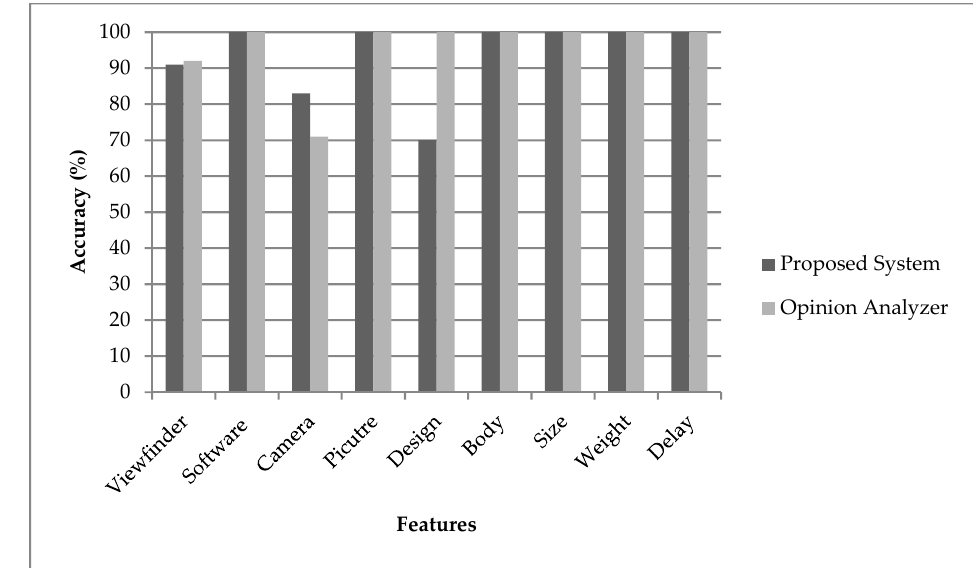
Figure 12. Comparison of proposed system with opinion analyzer on positive ranking.